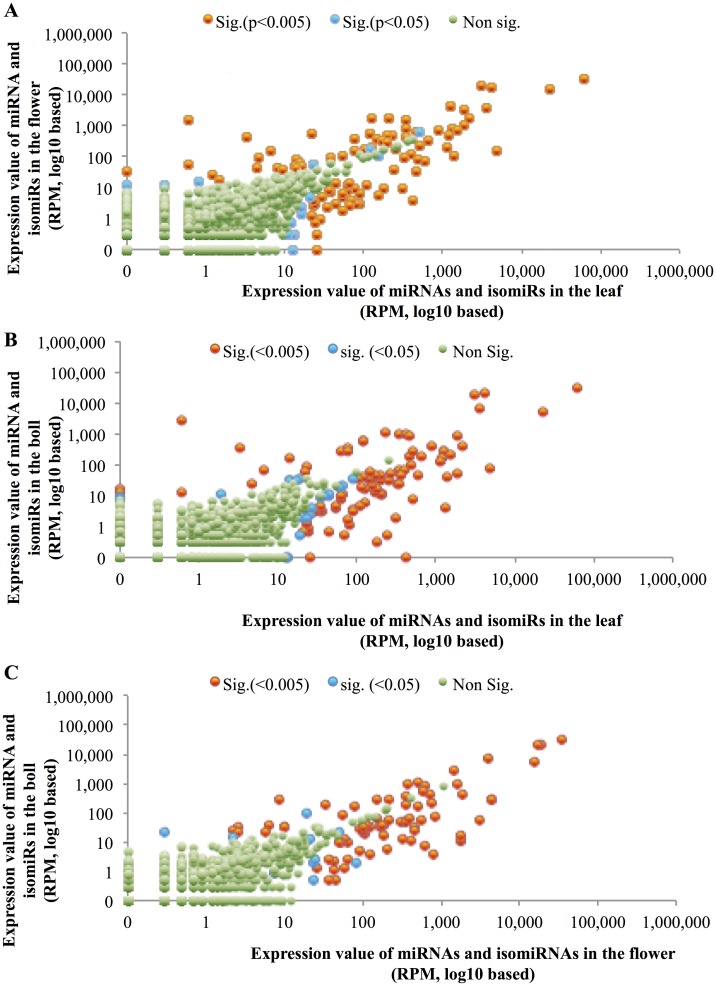
Differentially expressed miRNAs and isomiRNAs between different pairs of tissues.The differentially expressed miRNAs and their isomiRNAs are shown in A (leaf vs. flower), B (leaf vs. boll), and C (flower vs. boll). Red and blue dots indicated sequences that are significantly changed with FDR p-value of < 0.005 and 0.05, respectively, while the light green dots represent mostly low abundance sequences that are not significantly differentially expressed or higher abundance sequences that are not differentially expressed in the tissue comparisons being made.